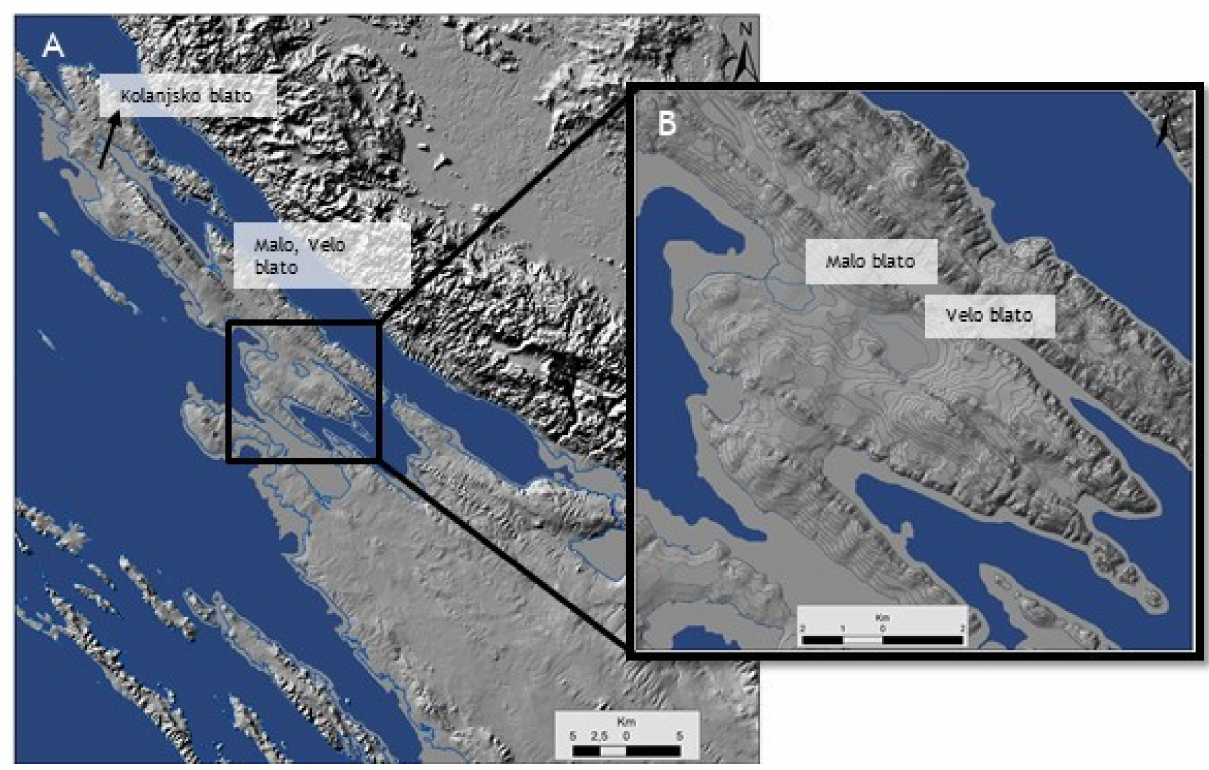
Figure 12. ( A ) Paleoshoreline of the eastern Adriatic coast at approximately 9000 years BP